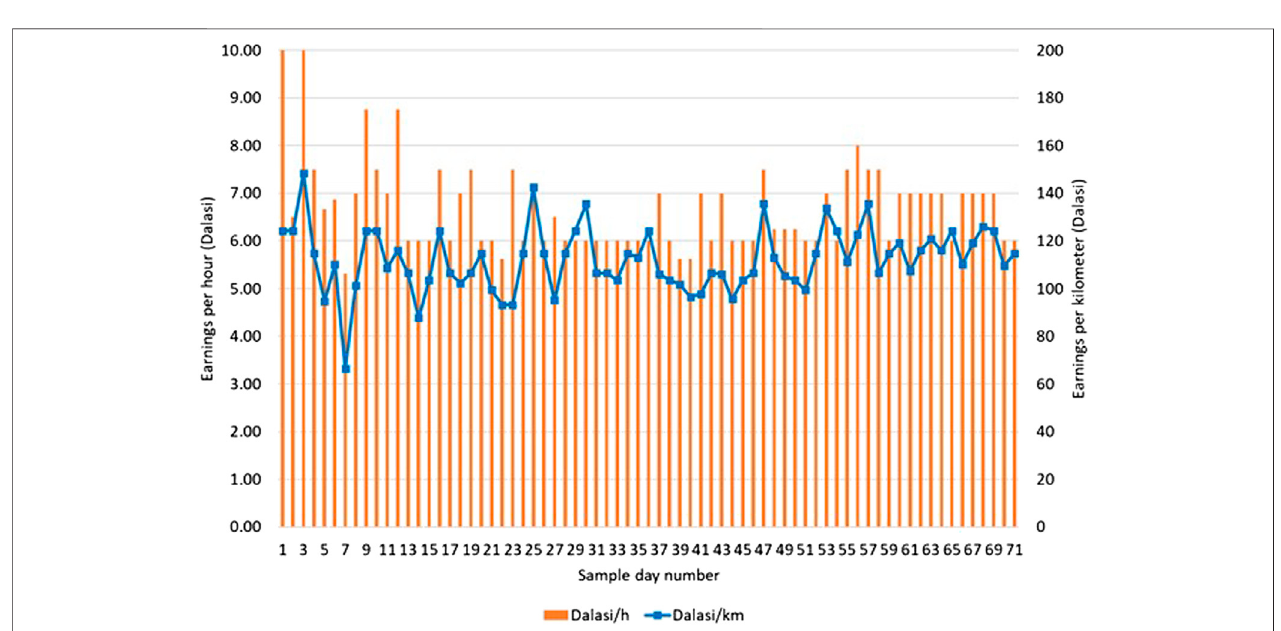
FIGURE 9 | Daily earnings in Gambian Dalasi (GMD) on a per-hour and per-kilometer basis.